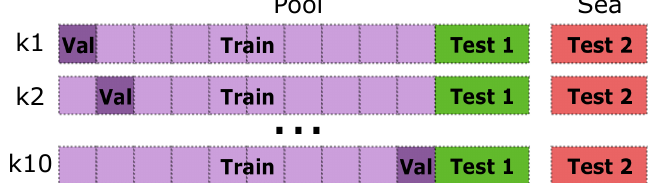
Figure 6. Implementation of the 10k-fold cross-validation